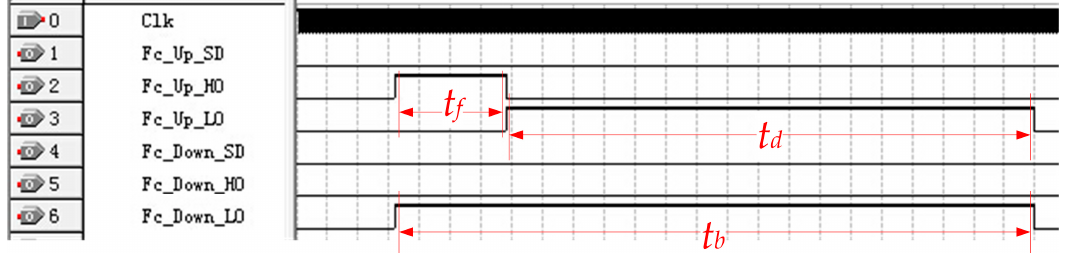
Figure 8. Control sequence of CPLD. t f is the excitation pulse width and t f = 1/2 f s ; t d is the discharge duration of the transducer; The blind zone duration t b = t f + t d , during which echo signal detection is not performed.